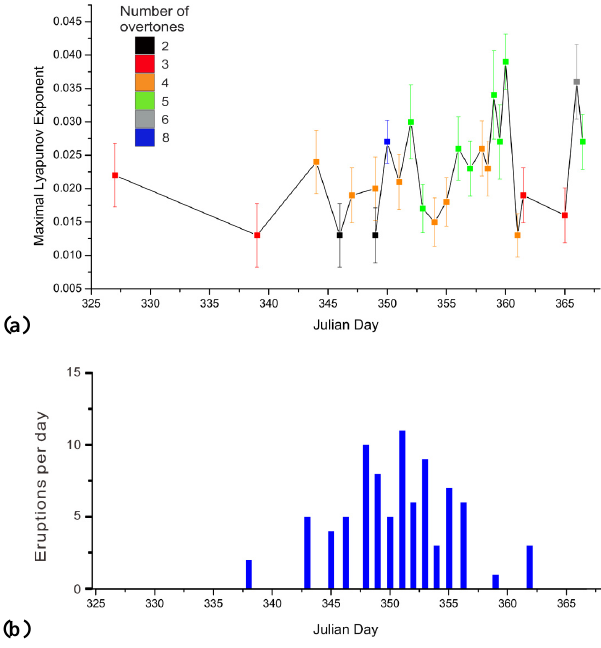
Fig. 9. (a) Diagram showing the temporal variation of MLEs and its relationship with the number of overtones for the tremor events under study. The vertical bars indicate the corresponding error of each MLE estimate. Number of frequency overtones for each tremor event is also shown using a color scale. (b) Temporal variations of number of eruptions per day for the same time period as registered by the Gunung Sawur volcano observatory. Visual observations of eruptions start from 4 December (Julian day 338) until 31 December (see text for more